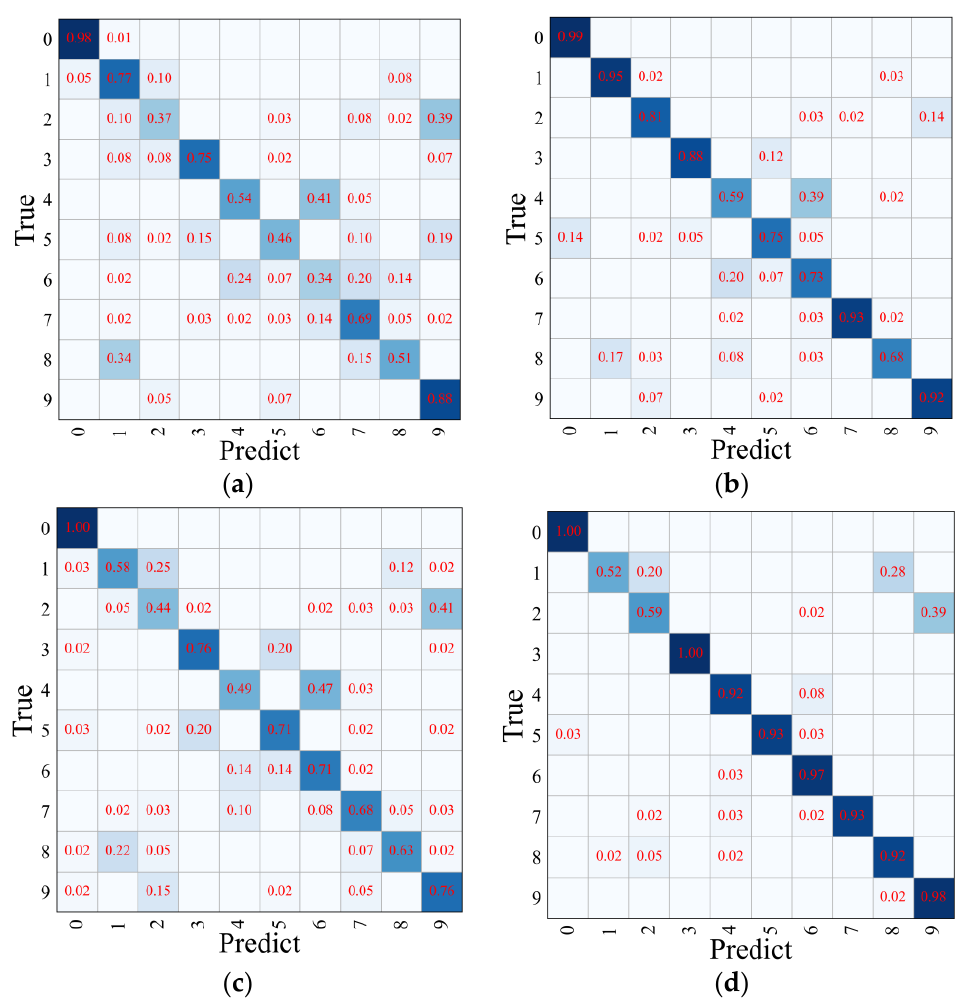
Figure 8. ( a ) CNN model fault classification ability; ( b ) DRSN model fault classification ability; ( c ) ACGAN+CNN model fault classification ability; ( d ) ACGAN+DRSN model fault classification ability. The darker the blue squares in these figures, the higher the probability that the fault will be correctly classified.